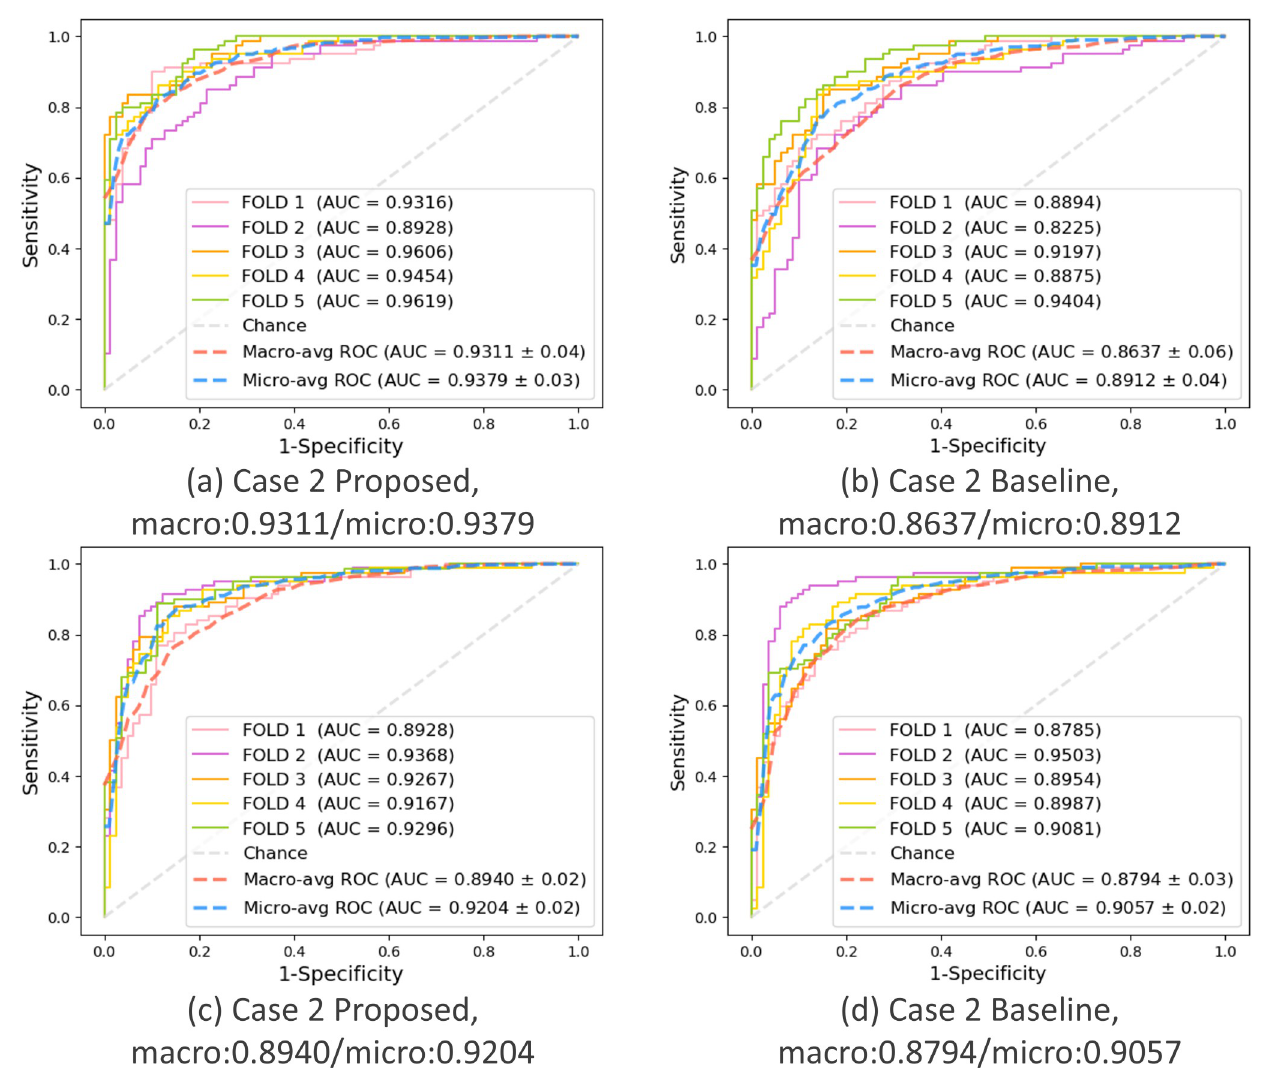
Fig 6. Case 2: Ataxia vs. others. Comparison of the performance between the proposed and baseline schemes in terms of AUC. (a) Autumn + proposed, (b) Autumn + baseline, (c) Number + proposed, (d) Number + baseline.